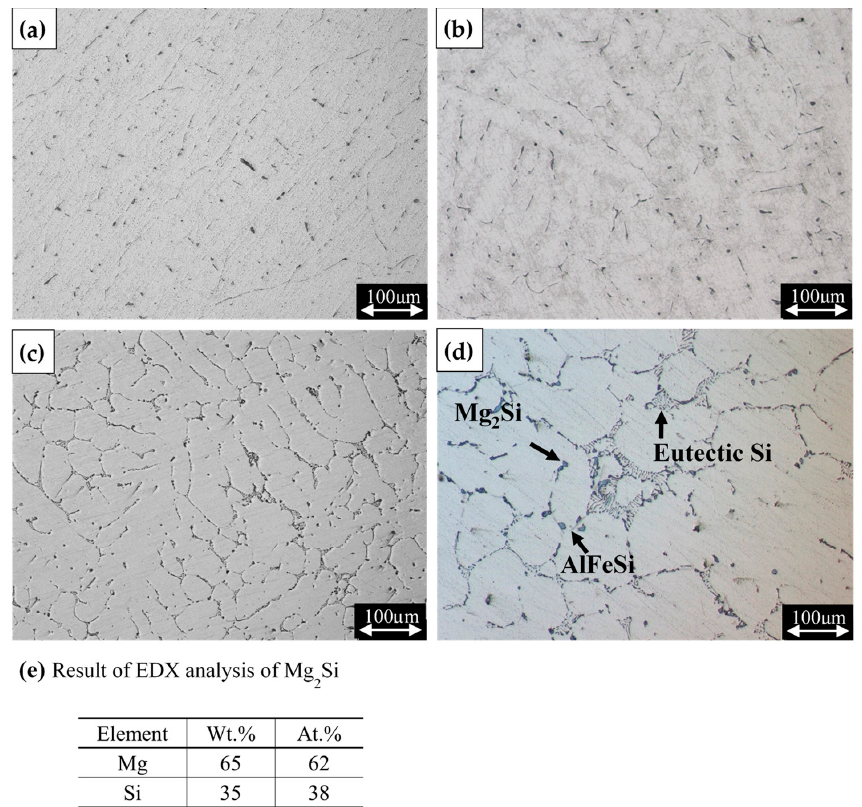
Figure 1. Optical micrographs of as-cast Al-Mg 2 Si alloys: ( a ) Al-1.1Mg 2 Si; ( b ) Al-1.9Mg 2 Si; ( c ) Al-3.5Mg 2 Si; ( d ) high magnification of Al-3.5Mg 2 Si (×500); and ( e ) result of energy dispersive X-ray spectroscopy (EDX) analysis of Mg 2 Si phase (black phase in ( d )).